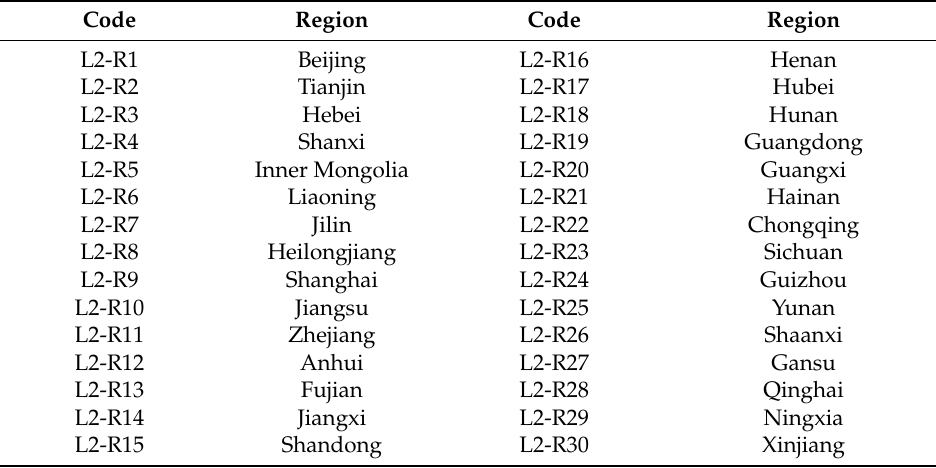
Table A1. Regions in this